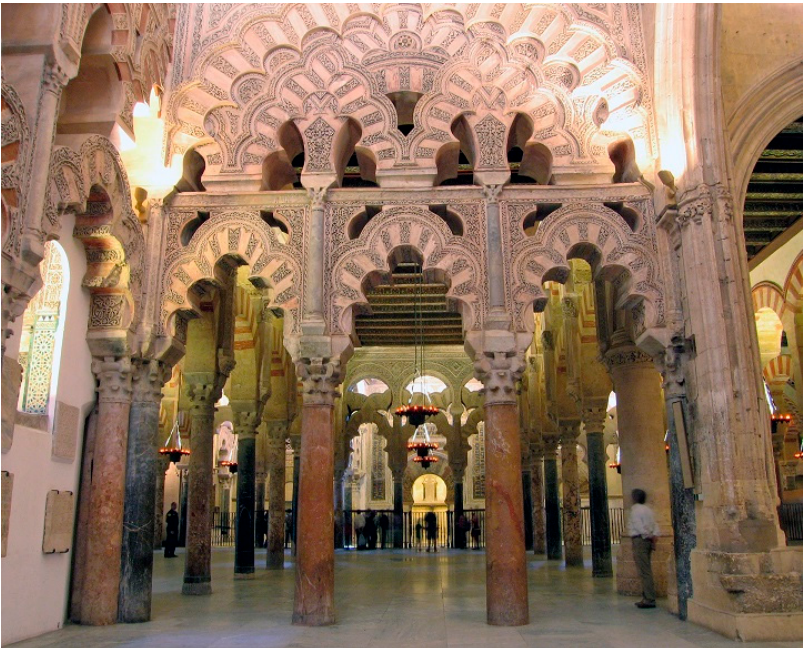
Figure 6. Great Mosque of Cordoba. Northern end of the axial nave of the caliphal enlargement (now